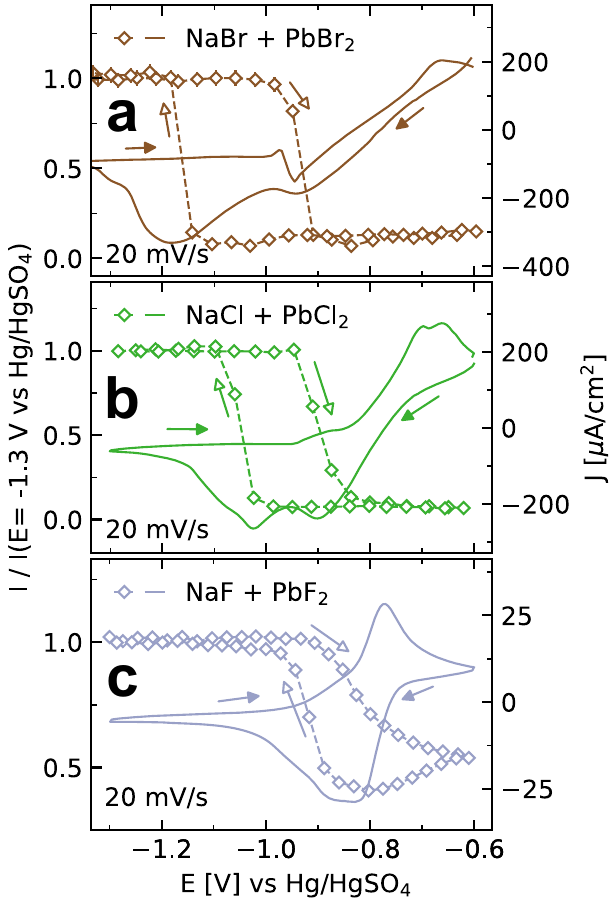
Fig. 3 | Potentiodynamic changes in the Hg interface structure in Pb halide solution. X-ray intensity I (open symbols),normalized by the intensity at1.3V,at a q z =0.50Å − 1 and b , c q z =0.45Å − 1 , recorded during cyclic voltammograms (solid lines)ofHgat20mV/s in a 0.01MNaBr+0.25mMPbBr 2 , b 0.01MNaCl+0.25mM PbCl 2 , and c 0.01M NaF+0.12mM PbF 2 . Arrows indicate the directions of the potential sweeps.